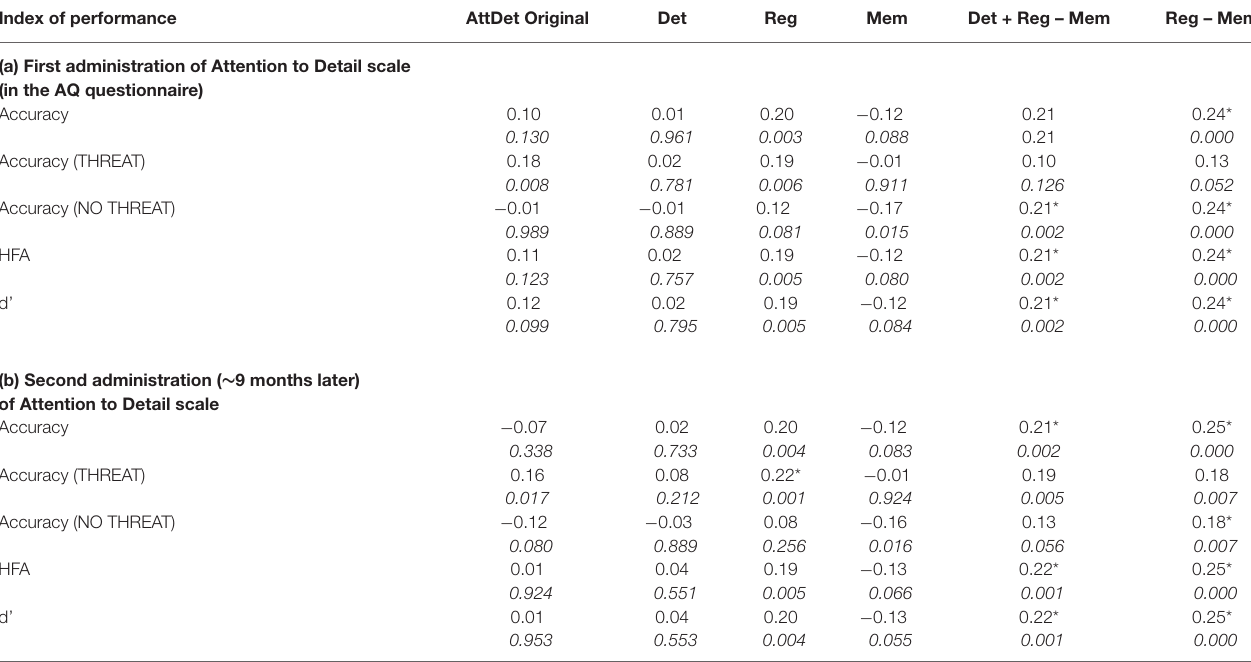
TABLE 3 | Spearman’s correlations ( N = 215) between indices of performance in x-ray screening and several combinations of items contained in the Attention to Detail (AttDet) subscale (first (a) and second (b) administration). Index of performance AttDet Original Det Reg Mem Det + Reg – Mem Reg – Mem